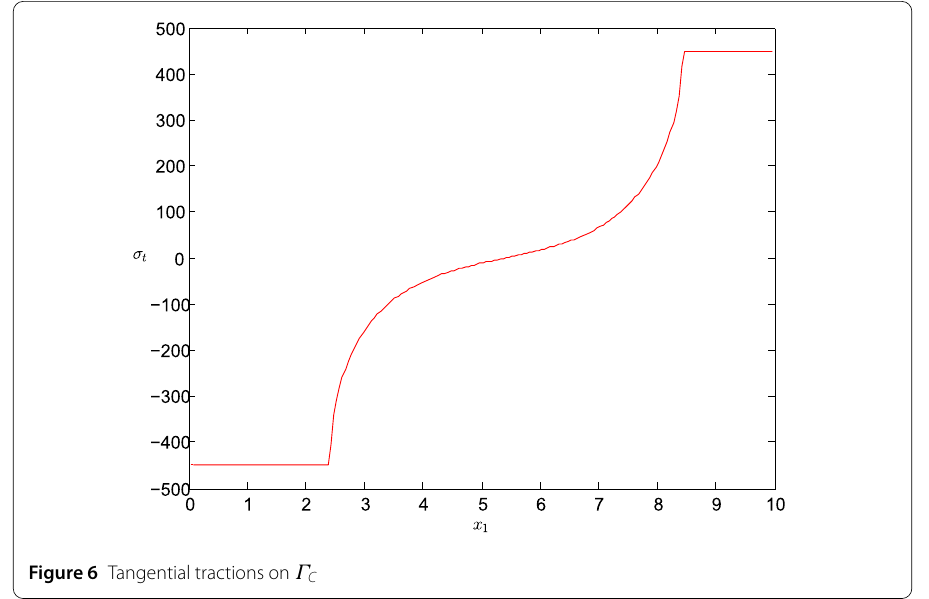
Figure 6 Tangential tractions on Γ C